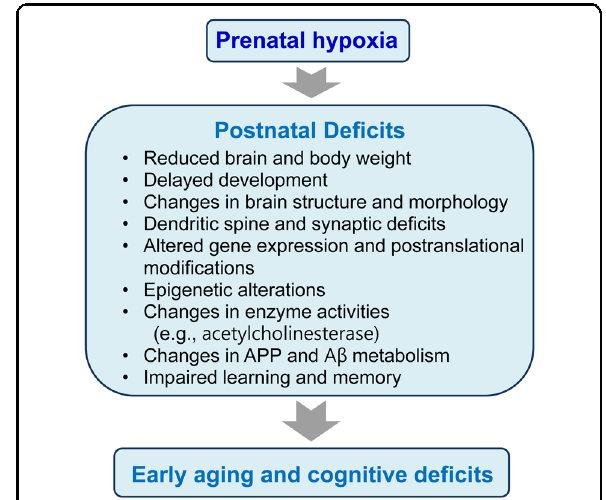
Fig. 7 Postnatal de fi cits observed in animal models of prenatal hypoxia are responsible for early aging and cognitive de fi